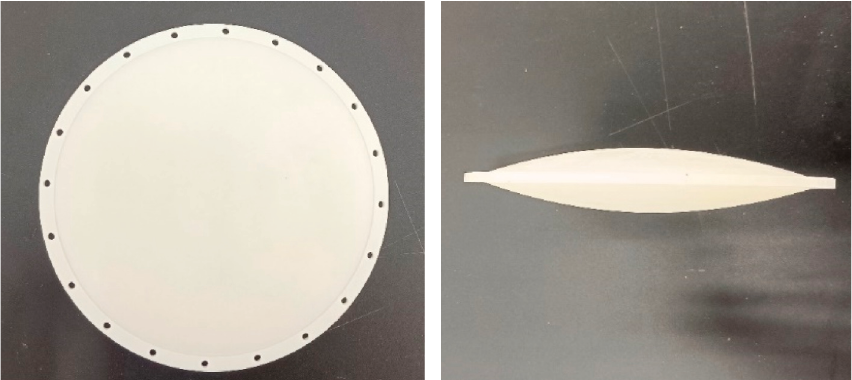
Figure 9: Dielectric lens prototype.